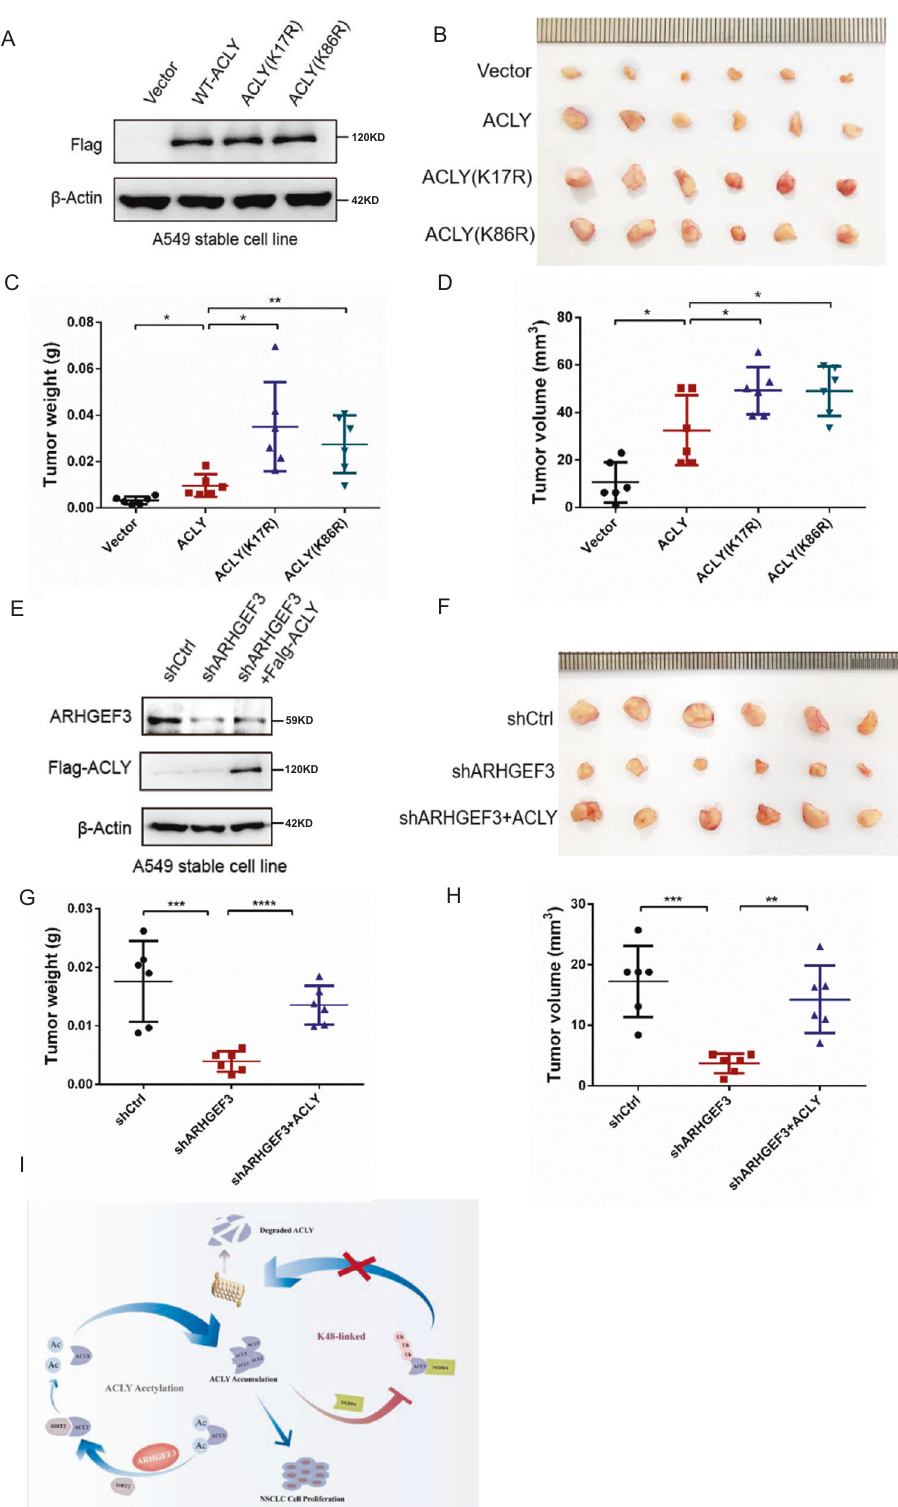
Fig. 8 ARHGEF3 promotes tumorigenesis by regulating the stability of ACLY. A Detection of expression effect of acetylation-de fi cient mutants. B The xenograft tumor model was constructed by A549 stable cell line with the overexpression of WT-ACLY, ACLY(K17R), and ACLY(K86R). C , D The weight and volume of xenograft tumors, p -value was calculated by paired t -test (mean ± SD, n = 6). * P < 0.05, ** P < 0.01. E Detection of expression effect of ARHGEF3 knockdown and ACLY overexpression. F The xenograft tumor model was constructed by A549 stable cell line with ARHGEF3 knockdown and ARHGEF3 knockdown combined with ACLY overexpression. G , H The weight and volume of xenograft tumors, p -value was calculated by paired t -test (mean ± SD, n = 6). ** P < 0.01, *** P < 0.001, **** P < 0.0001. I The working model of ARHGEF3 in regulating